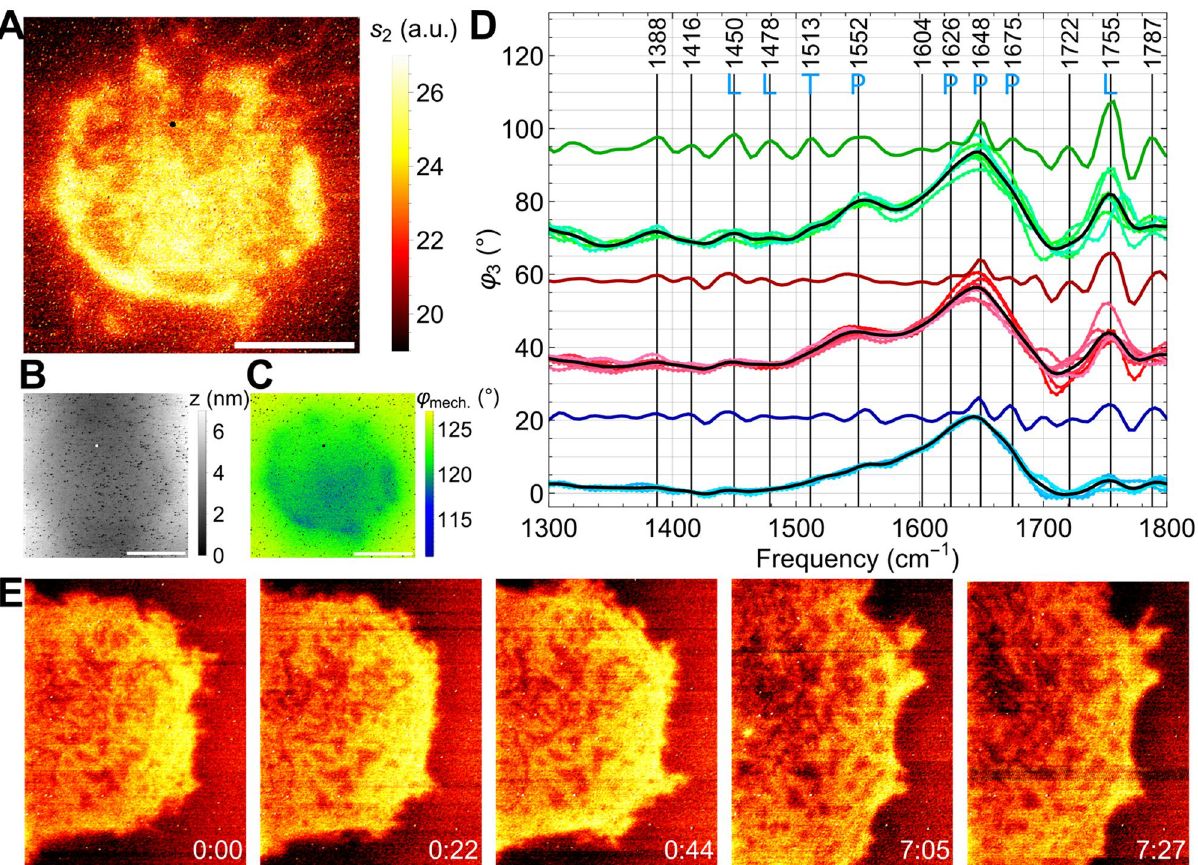
Figure 7. s-SNOM images and nano-FTIR spectra of living A549 cancer cells, ( A ) infrared amplitude s 2 image taken 5 h after drop-casting the cell suspension on the 10-nm SiN membrane (250 × 250 µm 2 , Norcada NX5025Z), ( B ) simultaneously registered topography z and ( C ) AFM phase φ mech images exhibiting patches interpreted as adhesion footprint, scale bars 5 µm; ( D ) nano-FTIR phase spectra φ 3 at a few arbitrary positions within a bright peripheral spot (green data points, taken in 4 min each), or in between such spots (red), or outside the cell’s footprint (blue); average spectra (black curves) and their calculated negative 2nd derivatives (coloured curves), with frequencies stated for the peaks in the green curve together with their assignments as P-protein, L-lipid, T-tyrosine, ( E ) infrared amplitude s 2 images (11.6 × 15.1 µm 2 ) of another A549 cell, corrected for sample drift, continuously acquired for 7:27 h in 22 min sequence starting 5 h after drop-casting, of which the first three and the last two are